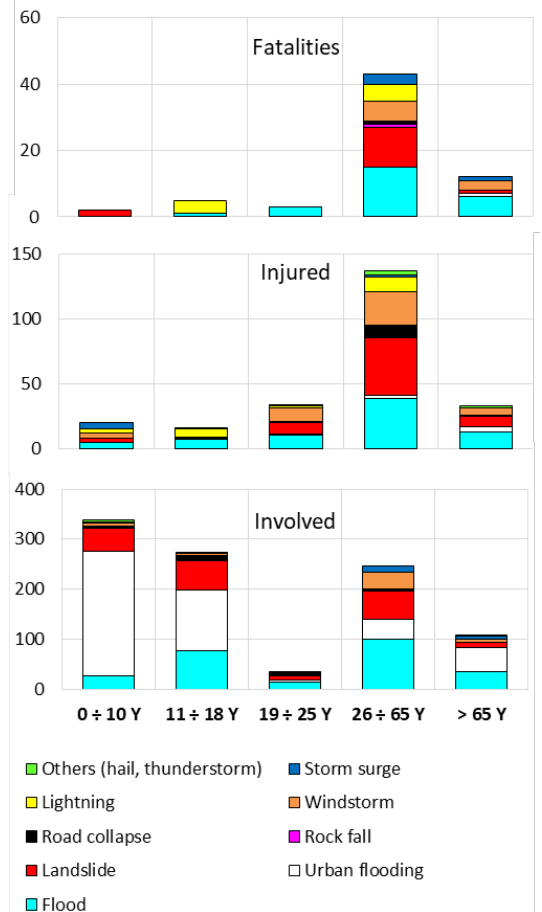
Figure 5. Relationships between age and type of phenomena (See also Appendix A: Table A1).